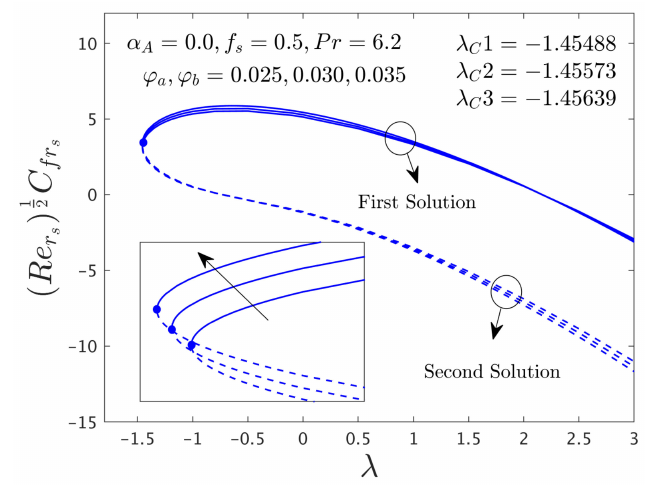
C fr against λ for numerous choices of hybrid nanoparticles. s s